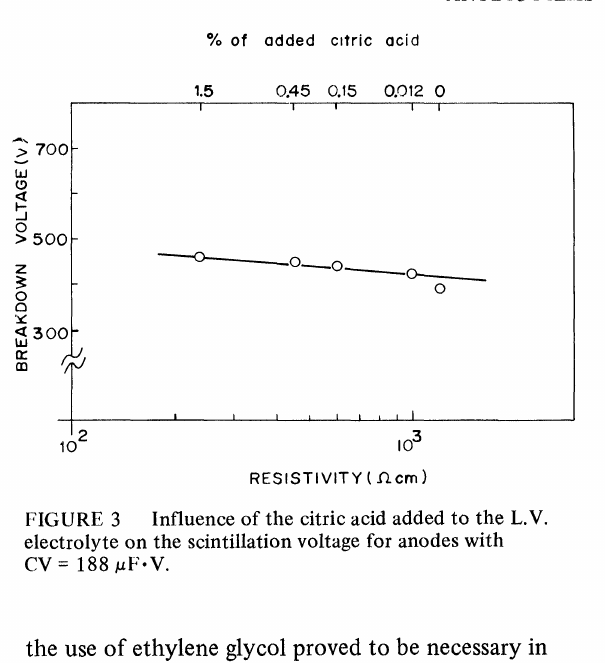
Influence of the citric acid added to the L.V. electrolyte on the scintillation voltage for anodes with CV 188 uF.V.